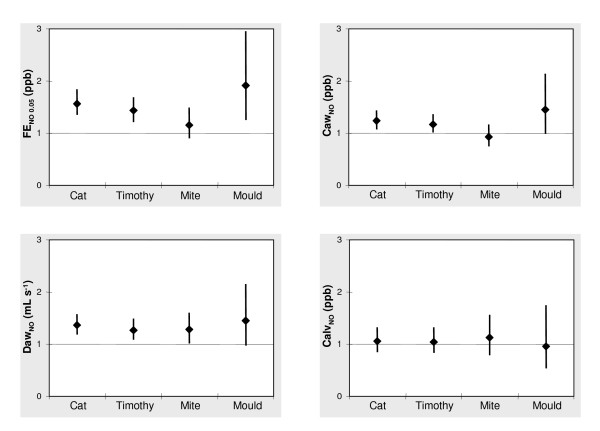
Exhaled NO ratio and flow-independent airway NO exchange parameters ratio between sensitised and non-sensitised subjects to a specific allergen (ratio of geometric means (95% CI)).